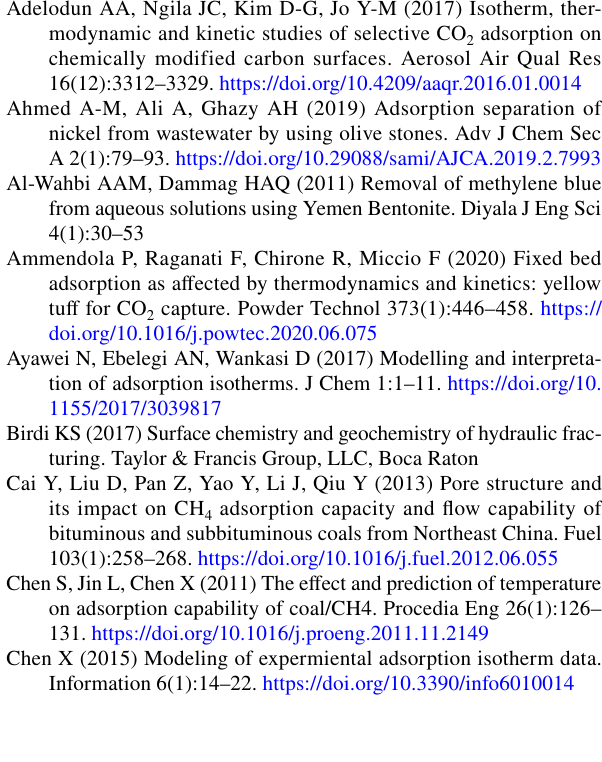
2 adsorption on Coal